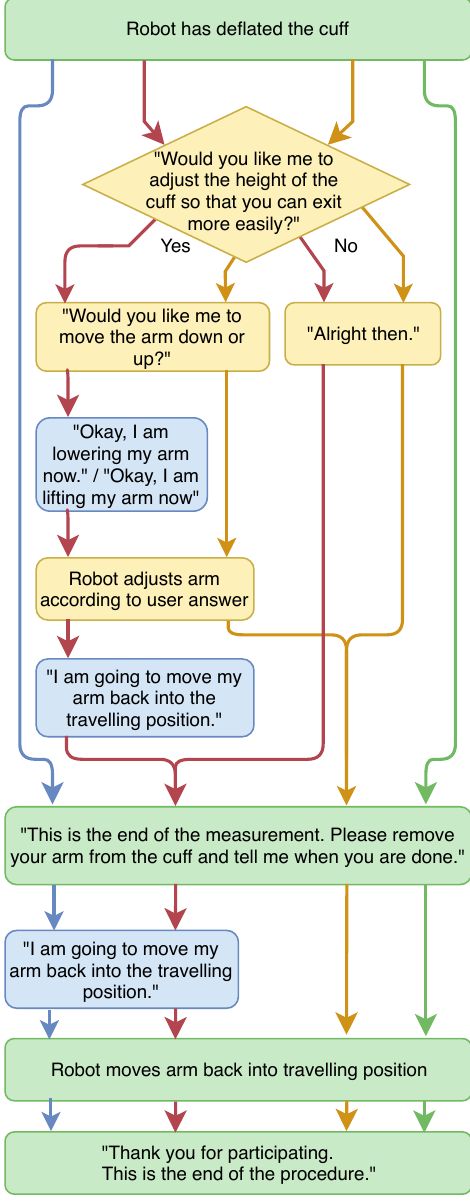
Figure 8: Flow chart of the last third of the experiment. Behaviour and conditions marked as in Fig.